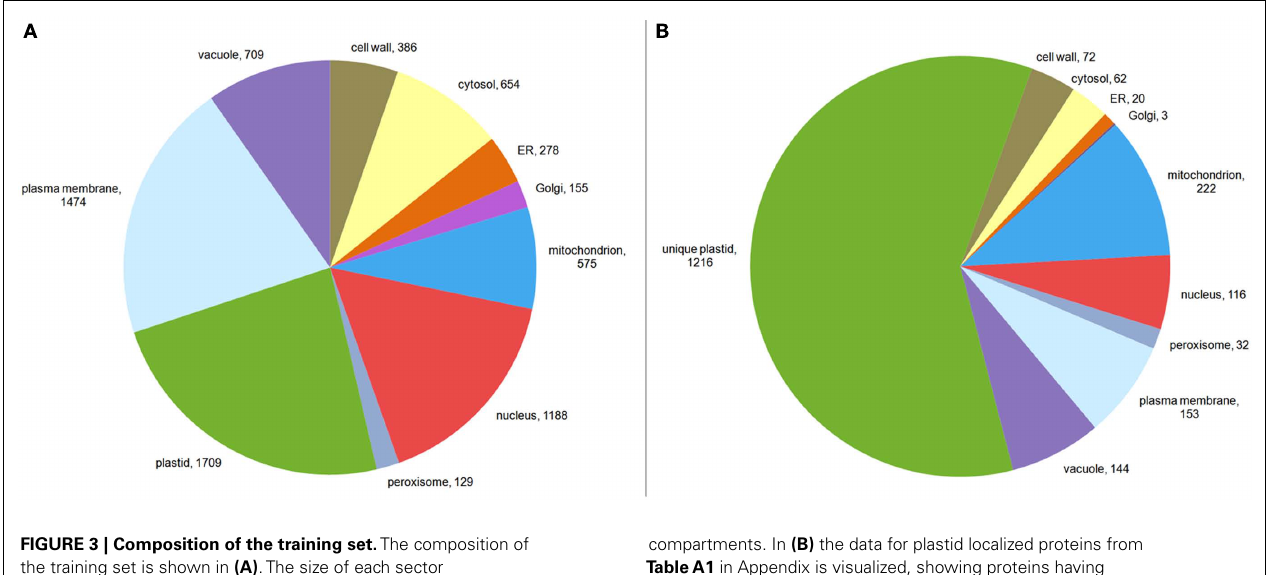
FIGURE 3 | Composition of the training set. The composition of the training set is shown in (A) .The size of each sector corresponds to all proteins in that compartment. Proteins localized to multiple compartments are counted toward each of their